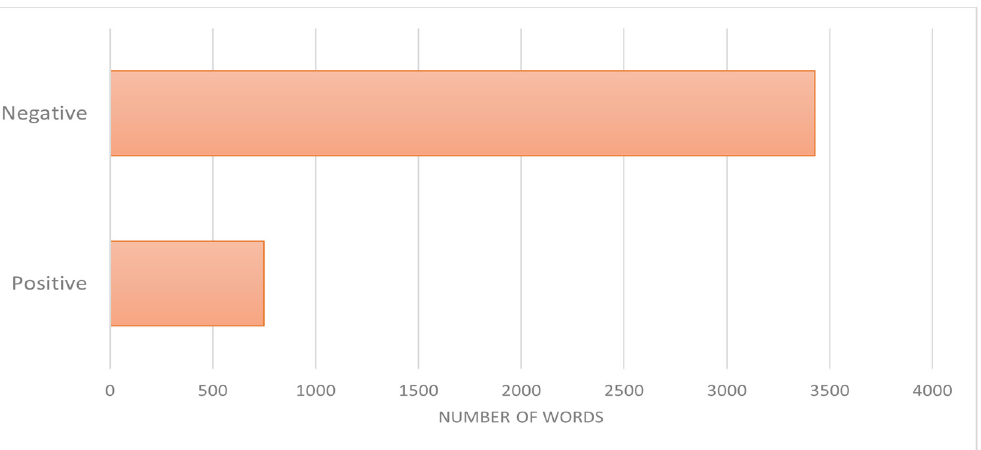
Figure 6. Sentiment analysis using the bing dictionary. Source: Own elaboration from texts from El País , El Mundo , ABC , elDiario.es , Público , and El Español .